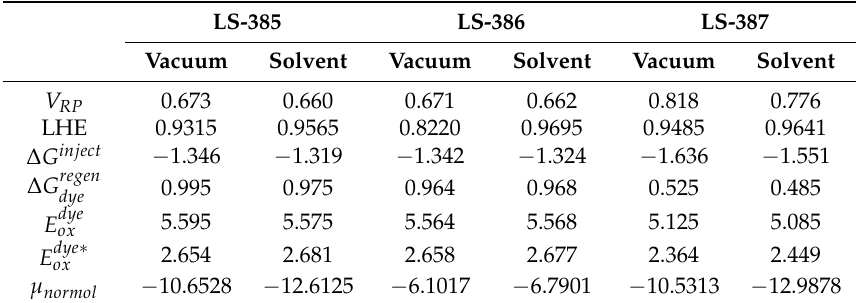
Table 5. The V RP , the light harvesting efficiencies (LHE), the electron injection free energy ( ∆ G inject , in eV), the oxidation potential of the dye in ground state ( E dye in excited state ( E dye ox , in eV), the dye regeneration free energy ( ∆ G regen moment of ( µ normol , in Debye) in vacuum and DMF